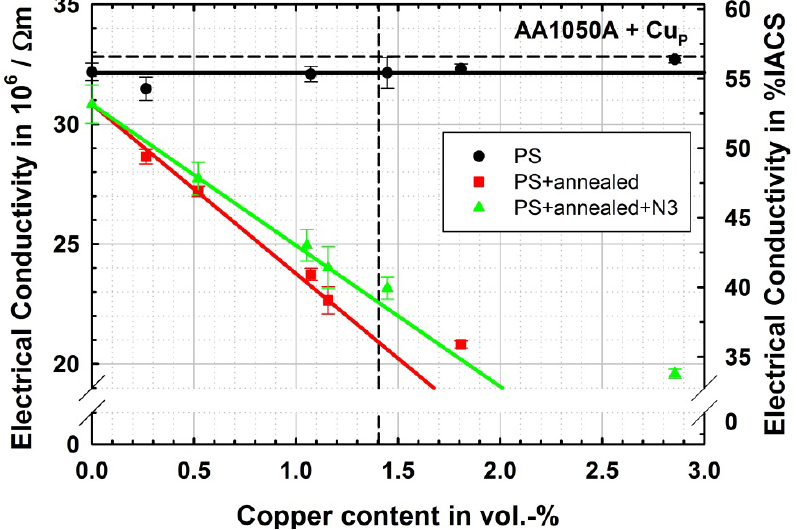
Figure 5. Electrical conductivity of the aluminum based materials in different microstructural states depending on the copper content. Dashed lines symbolize solubility of Cu in Al at 530 °C (vertical) and conductivity of AA1050A in CG state